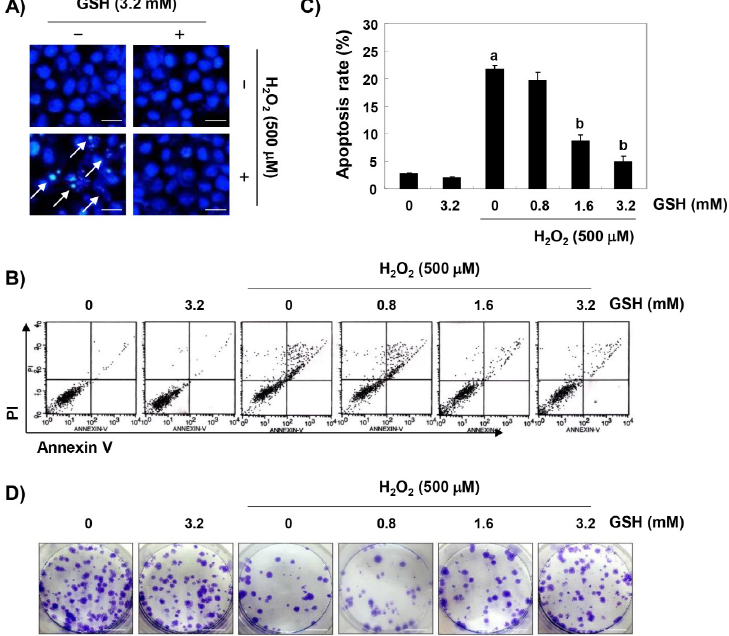
Figure 2. The inhibitory effects of glutathione against H 2 O 2 -induced apoptosis in RAW 264.7